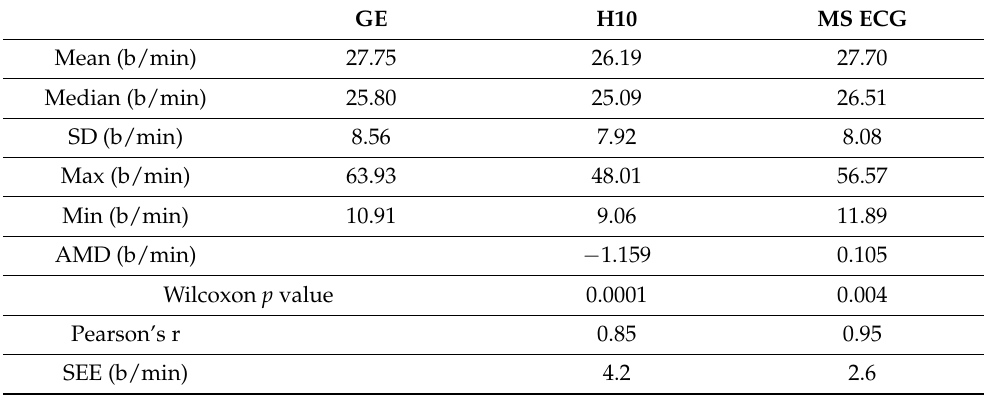
Table 1. Mean, standard deviation (SD), median, minimum, maximum, adjusted median difference (AMD) as breaths/min (b/min) for the respiratory frequency (RF) comparison of the gas exchange (GE), Polar H10 (H10) and the Movesense Medical sensor ECG (MS ECG) data according to Hodges–Lehmann method (p-value estimated by Wilcoxon paired testing), Pearson’s r and standard error of estimate (SEE) calculated from paired RF data during the incremental exercise test until voluntary